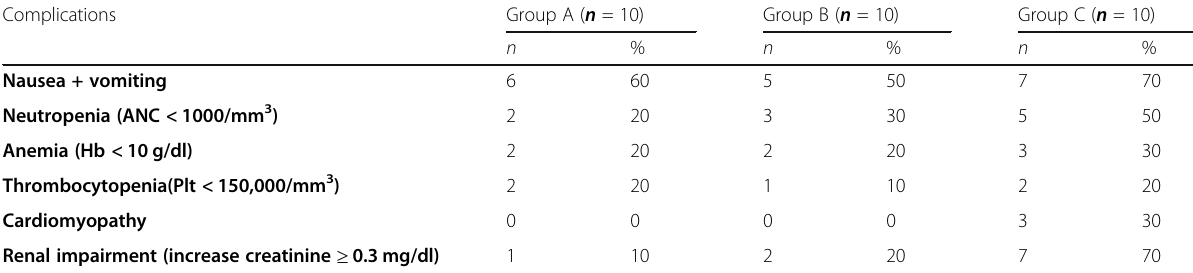
Table 3 Chemotherapy complications (CTCAE 2017)